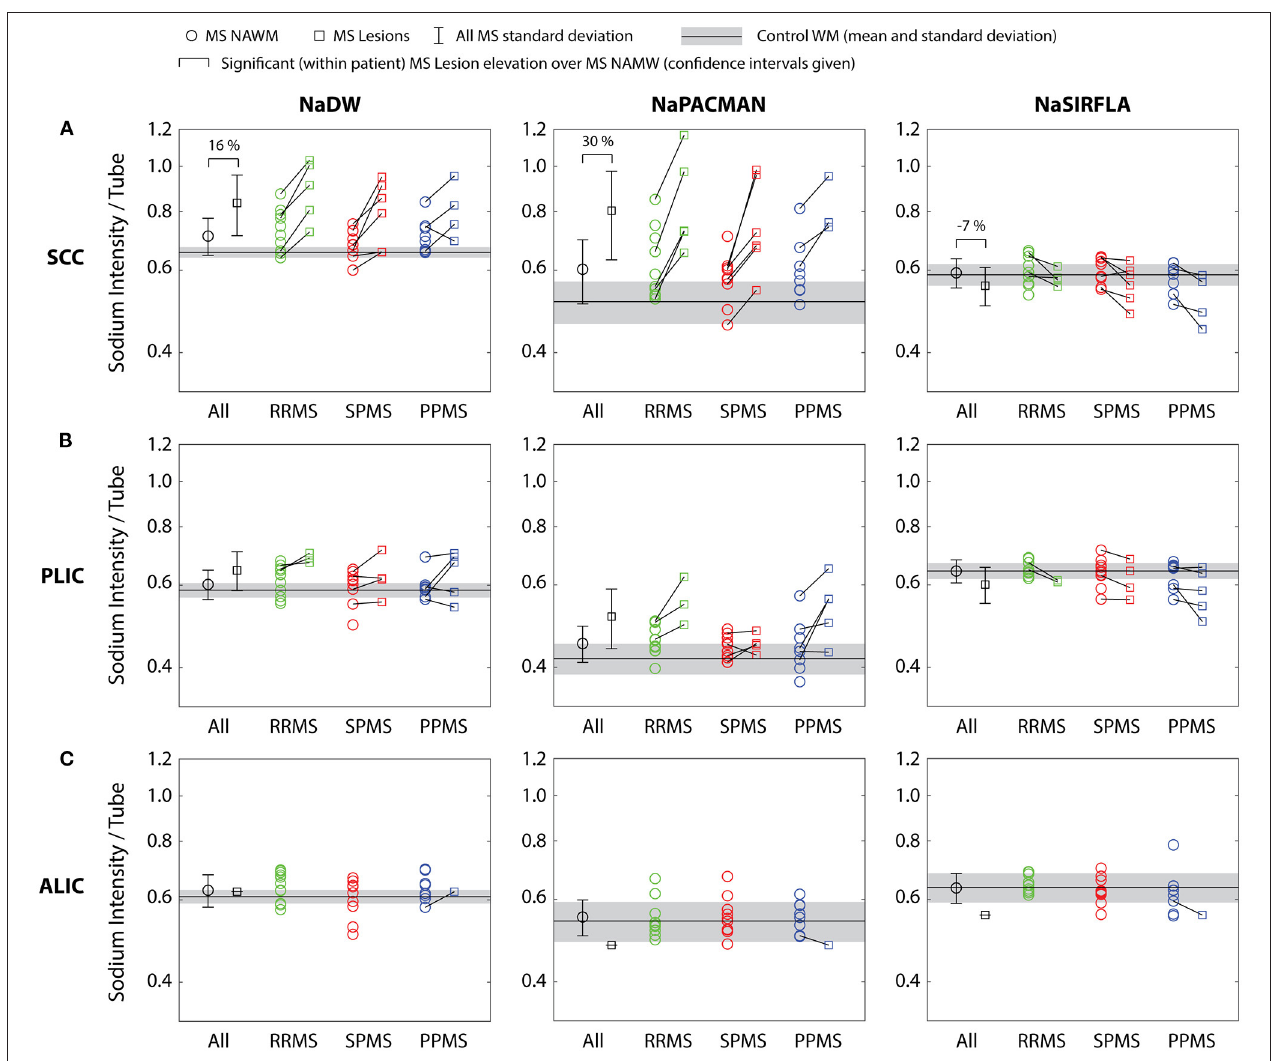
FIGURE 4 | (A) Lesions within the SCC have significantly greater signal than adjacent, directly comparable NAWM for both NaDW and NaPACMAN, with NaPACMAN yielding a relative difference ∼ 2 × greater than NaDW. Alternatively, NaSIRFLA shows a significant signal decrease in SCC lesions. (B,C) There were no significant findings in the PLIC or